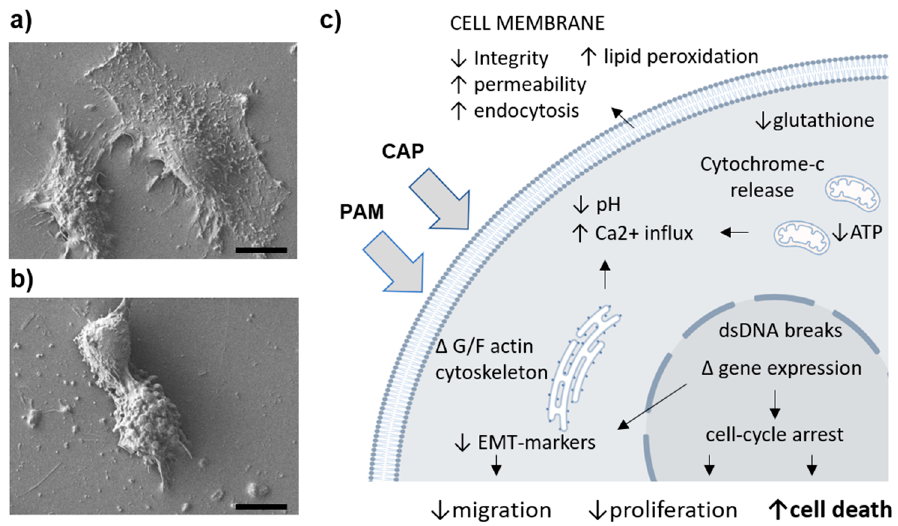
Figure 1. Cold atmospheric plasma poses effects on cellular morphology and various cellular pro- cesses. The appearance of ( a ) non-treated and ( b ) plasma treated immortalized fibroblasts showing reduced cell proliferation, cell rounding, and cell death, 24 h upon high dose plasma exposure. ( c ) A schematic overview synthesizing plasma induced (intra)cellular perturbations affecting some major cell processes. Scale bar 10 µm.